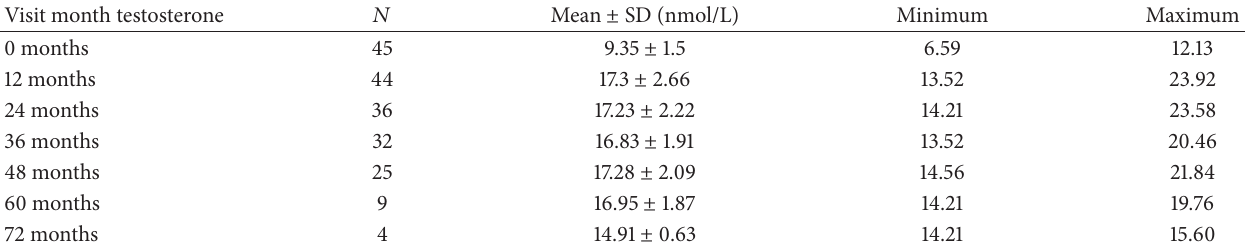
Table 2: Serum levels of testosterone over 72 months of testosterone treatment.